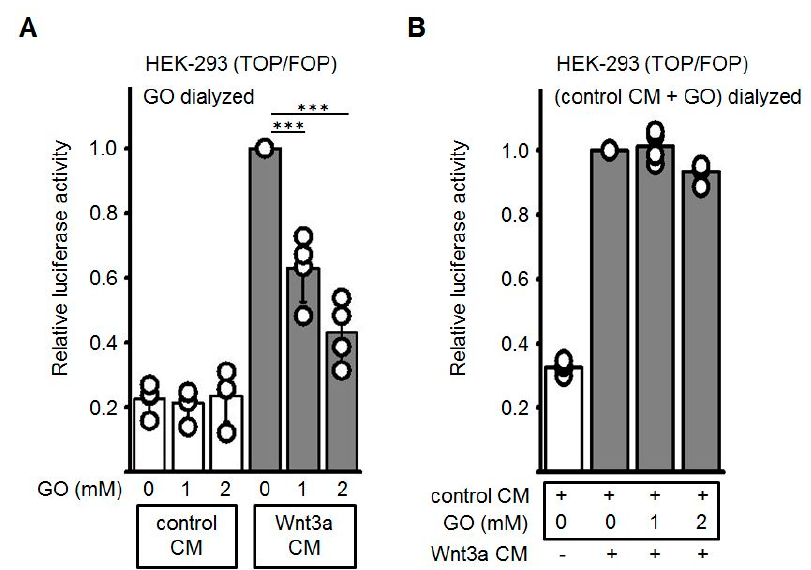
Figure 4. Effect of dialysis on GO-treated CM. Conditioned media were incubated with GO for 5 h at 37 °C and subsequently dialyzed overnight against PBS at 4 °C. ( A ) After GO removal, dose-dependent reduction of glycated Wnt3a CM activity was still detectable in Topflash/Fopflash reporter gene assays. ( B ) Dialyzed GO-treated control CM did not inhibit luciferase activity induced by non-glycated Wnt3a CM. Values of non-glycated Wnt3a CM were normalized to 1. The graphs show mean values ± SD of n = 4 independent experiments, each measured in duplicate. Circles represent individual experiments. Differences to non-glycated Wnt3a CM were analyzed by paired t-test. *** p < 0.001.